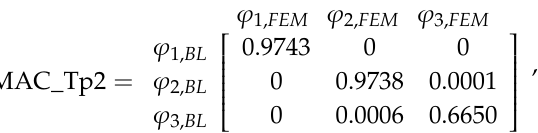
Figure 12. Eight -storey benchmark. Modal shapes comparison between the ( a ) FEM and ( b ) beam-like models.